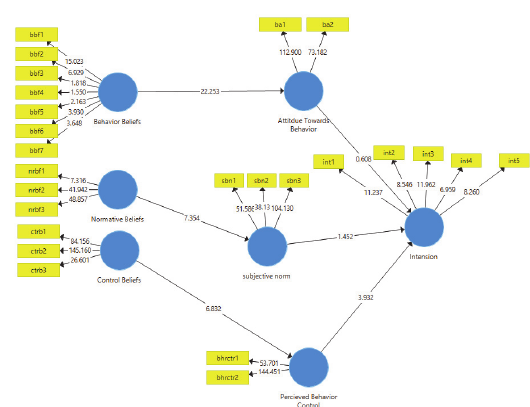
Fig. 3. Algorithm of the measurement model Fig. 4 . Bootstrapping the measurement